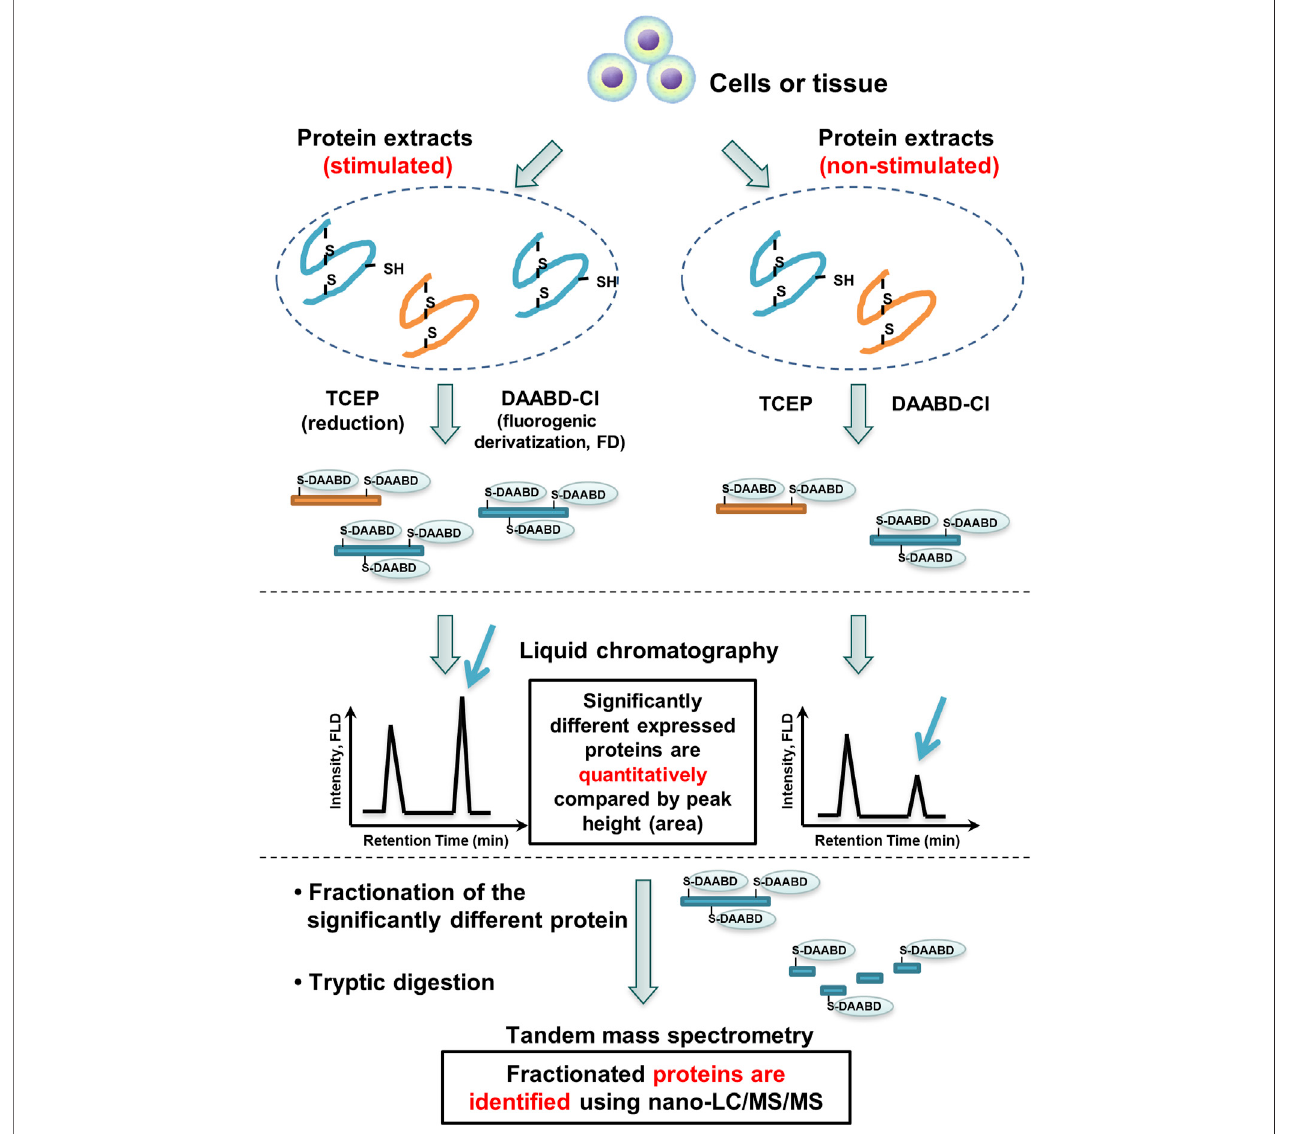
FIGURE 3 | FD-LC-MS/MS method for comprehensive differential proteomics